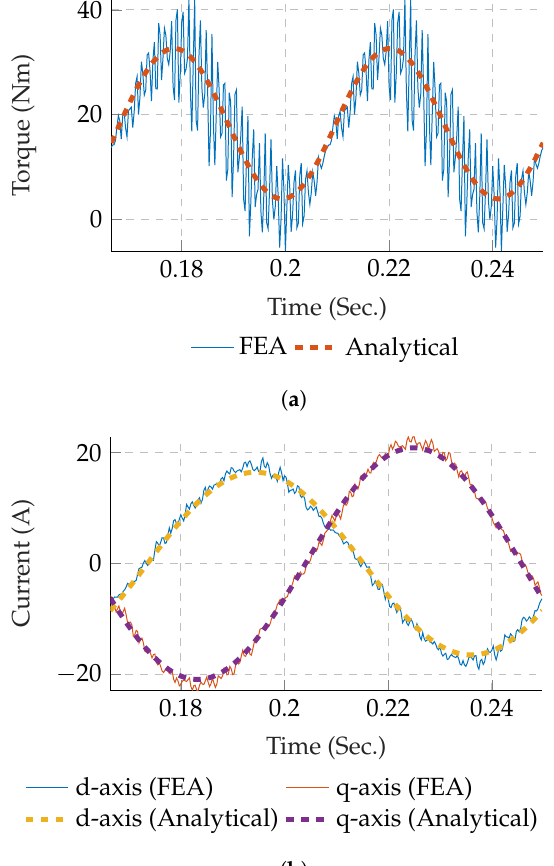
Figure 7. Steady state analysis results on 20% slip operation. ( a , b ) respectively compares torque and dq currents.